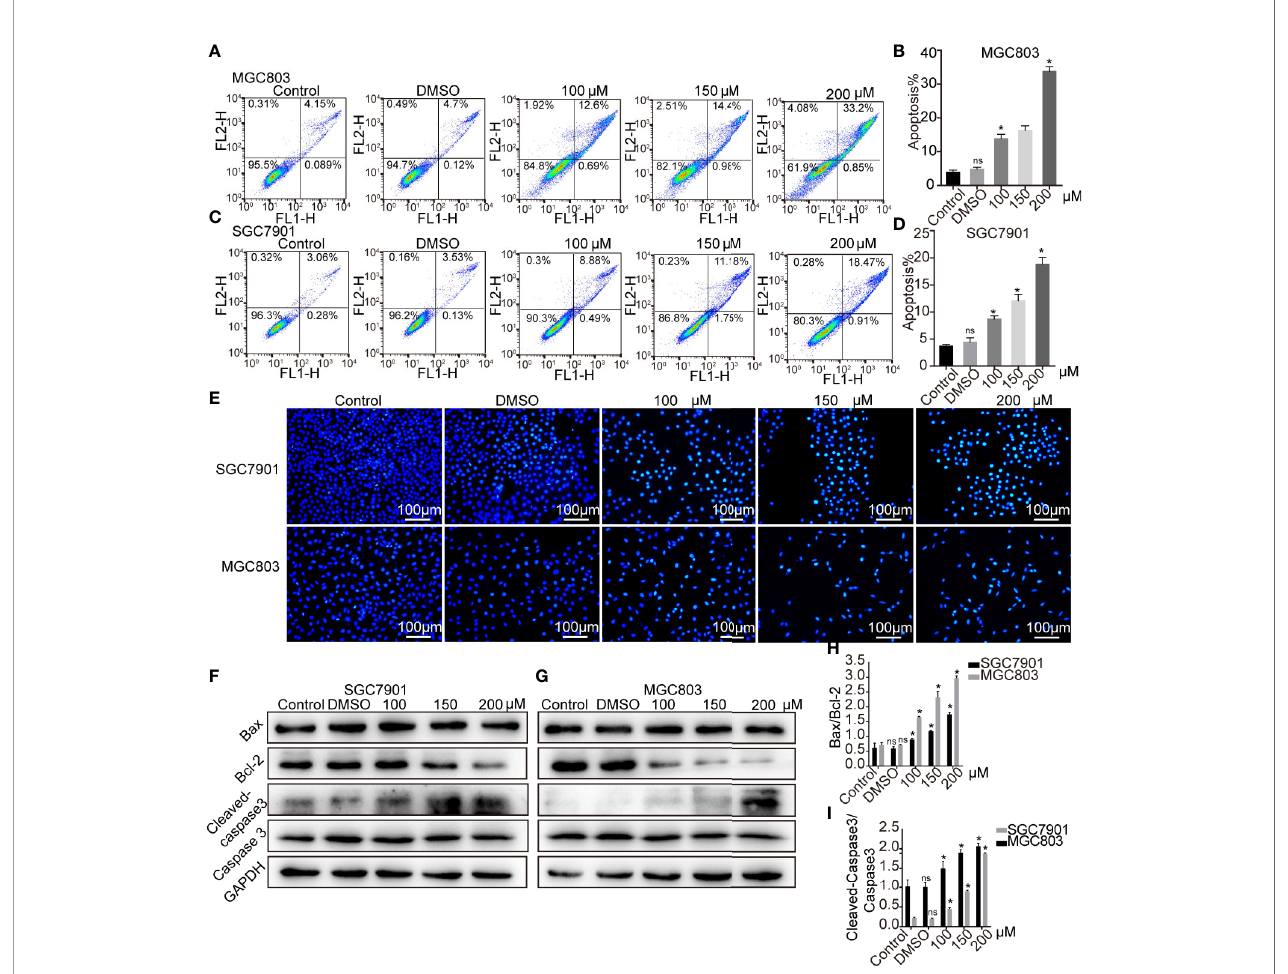
FIGURE 3 | Germacrone induced apoptosis in gastric cancer cells. (A – D) Annexin IV- fl uorescein isothiocyanate (FITC)/propidium iodide (PI) staining was used to assess the effect of germacrone on apoptosis by fl ow cytometry (FCM). (E) Hoechst 33258 staining was used to detect apoptosis. (F, G) Changes in the expression levels of BAX, Bcl-2, caspase-3, and cleaved caspase-3 were detected by western blot. (H, I) Changes in the BAX/Bcl-2 and cleaved caspase-3/caspase-3 ratios were analyzed after germacrone treatment. Data are the means ± SD of three experiments. * P < 0.05; ns, not signi fi